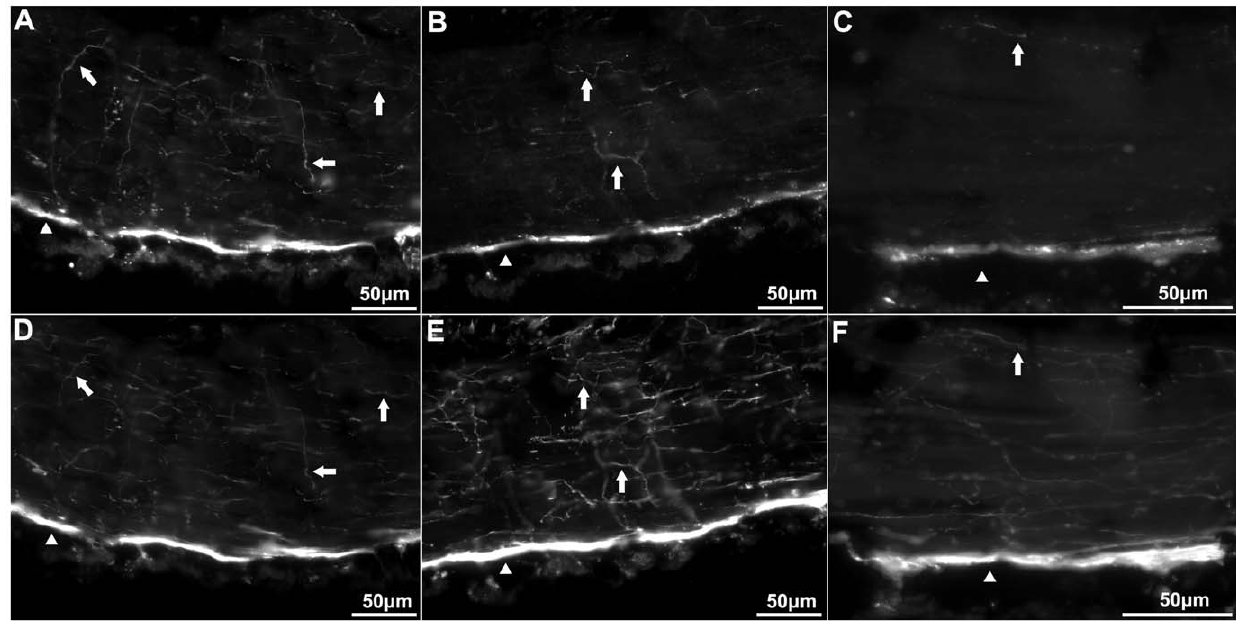
Figure 2. Anti-calbindin 1, anti-parvalbumin, and anti-calbindin 2 immunoreactivity in the peripheral nerve and circular muscle of Holothuriaglaberrima (Holothuroidea). Longitudinal sections through the body wall showing colabeling of anti-calbindin 1 (A) and RN1 (D), anti- parvalbumin (B) and RN1 (E), and anti-calbindin 2 (C) and RN1 (F). Most of the immunoreactivity was observed in the peripheral nerves (arrowheads), while only a minor supopulations of fibers were co-labeled by the anti-CBP and RN1 (arrows).